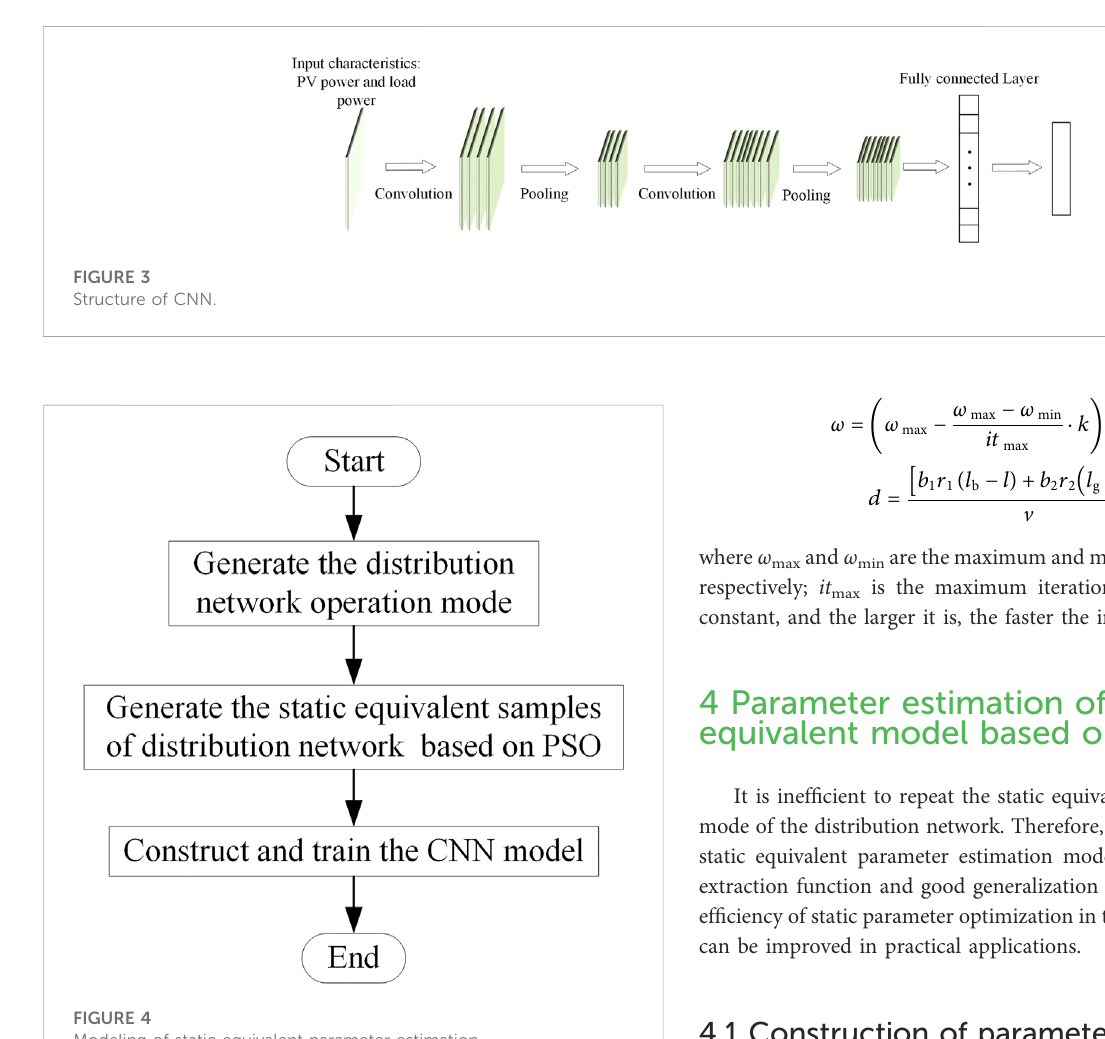
Modeling of static equivalent parameter